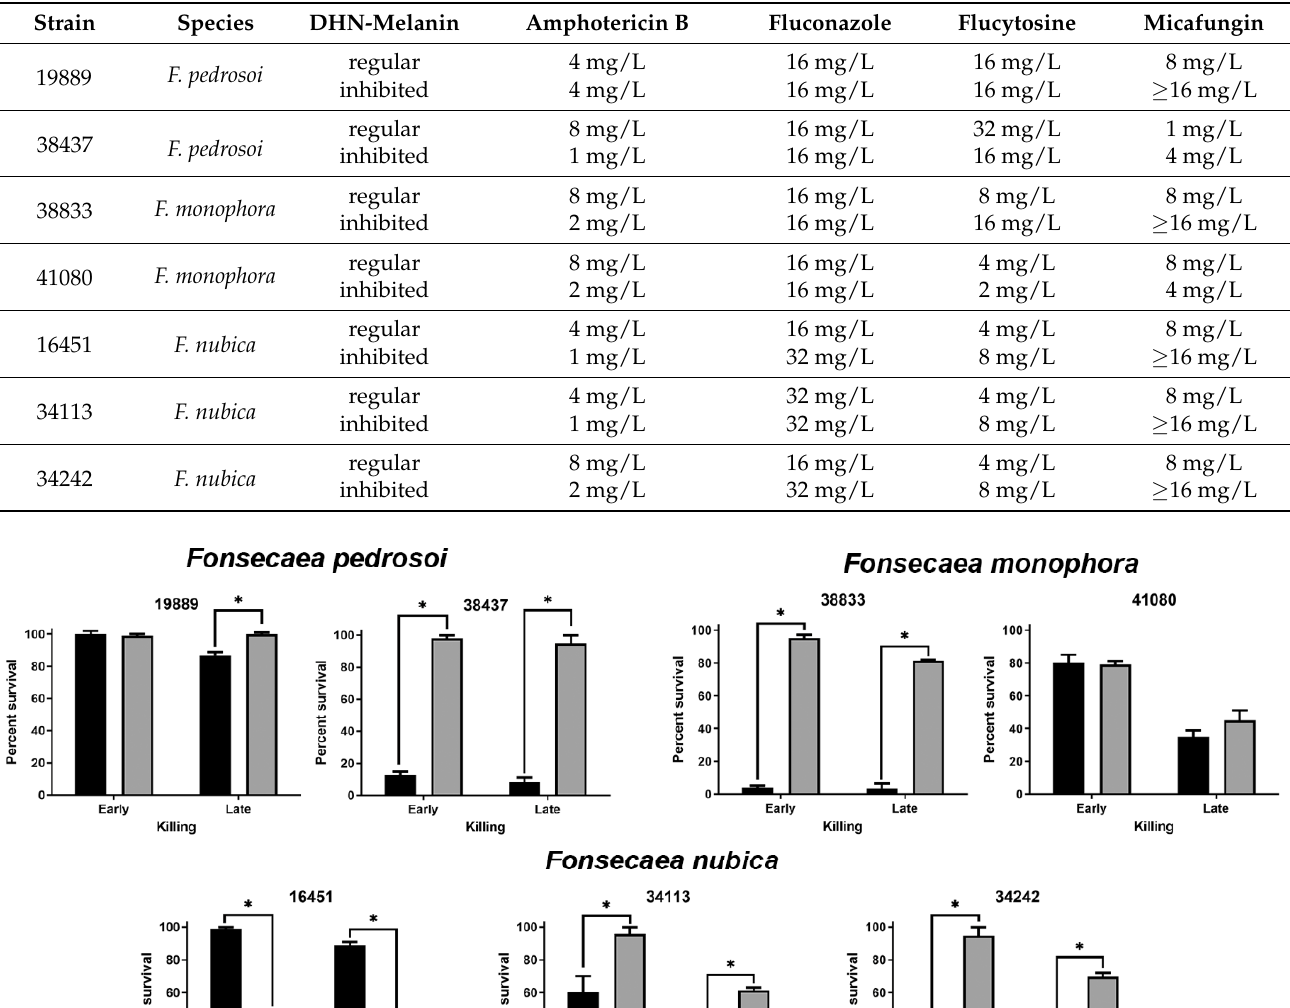
Table 1. Minimal inhibitory (or effective) concentrations of four antifungal drugs against seven Fonsecaea strains with regular or inhibited DHN-melanin production.